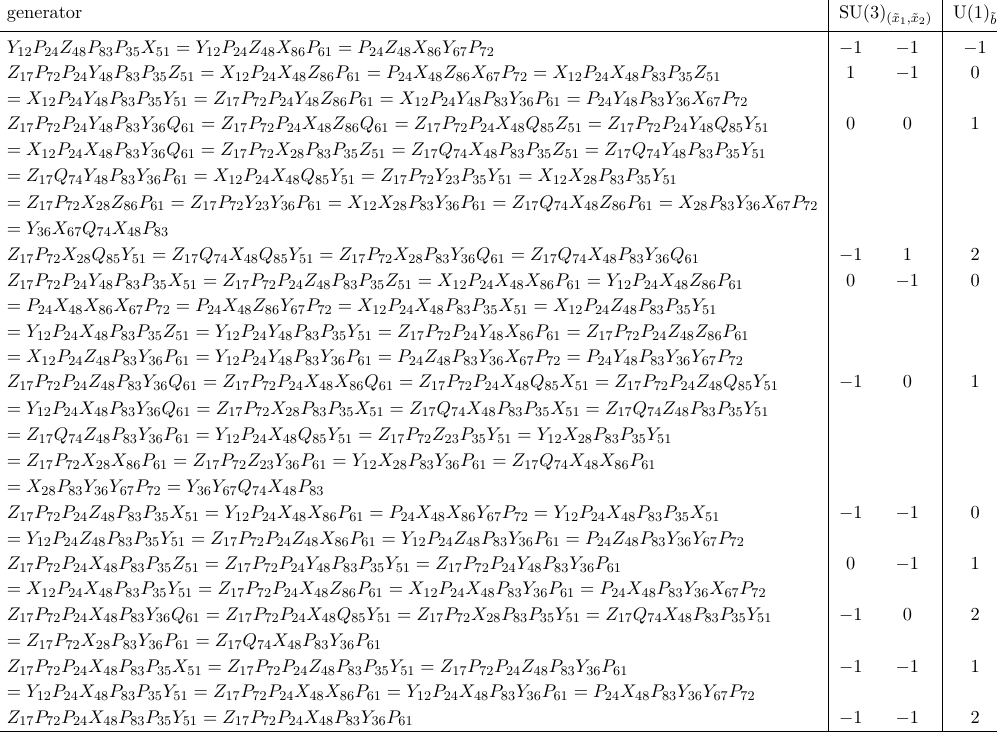
Table 30 . The generators in terms of bifundamental chiral fields for Model 7 (Part 2)